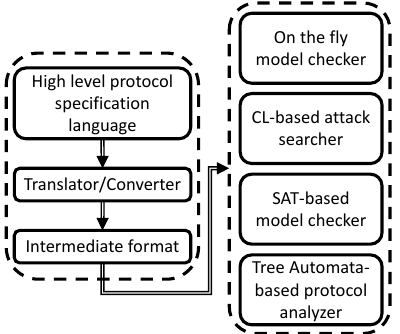
Figure 10. General structure of